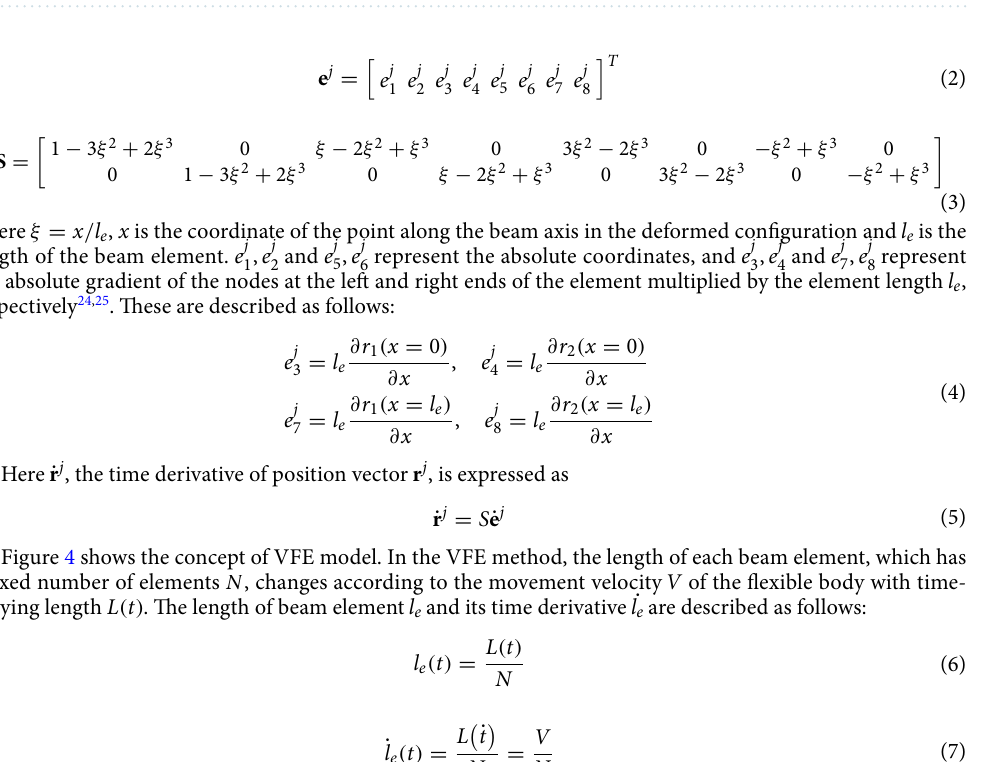
Figure 3. Model of a flexible pendulum. In VFE-ANCF model, each element length is same and changes evenly. On the other hands, in VB-VFE-ANCF model, the flexible pendulum was divided into two parts, and the element length of bodies A and B changes at different rates.